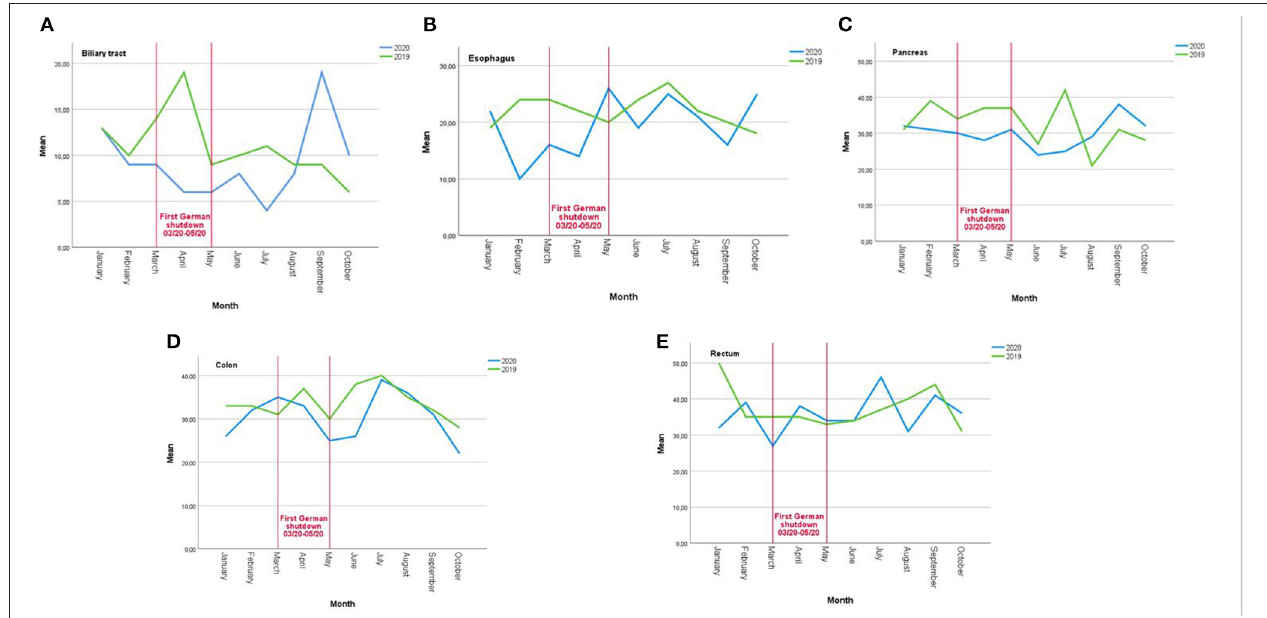
FIGURE 2 | Number of tumor board presentations for different cancer entities per month/year 2019 (pre-COVID-19 pandemic) vs. 2020 (during COVID-19 pandemic); (A) biliary tract, (B) esophagus, (C) pancreas, (D) colon, and (E) rectum.